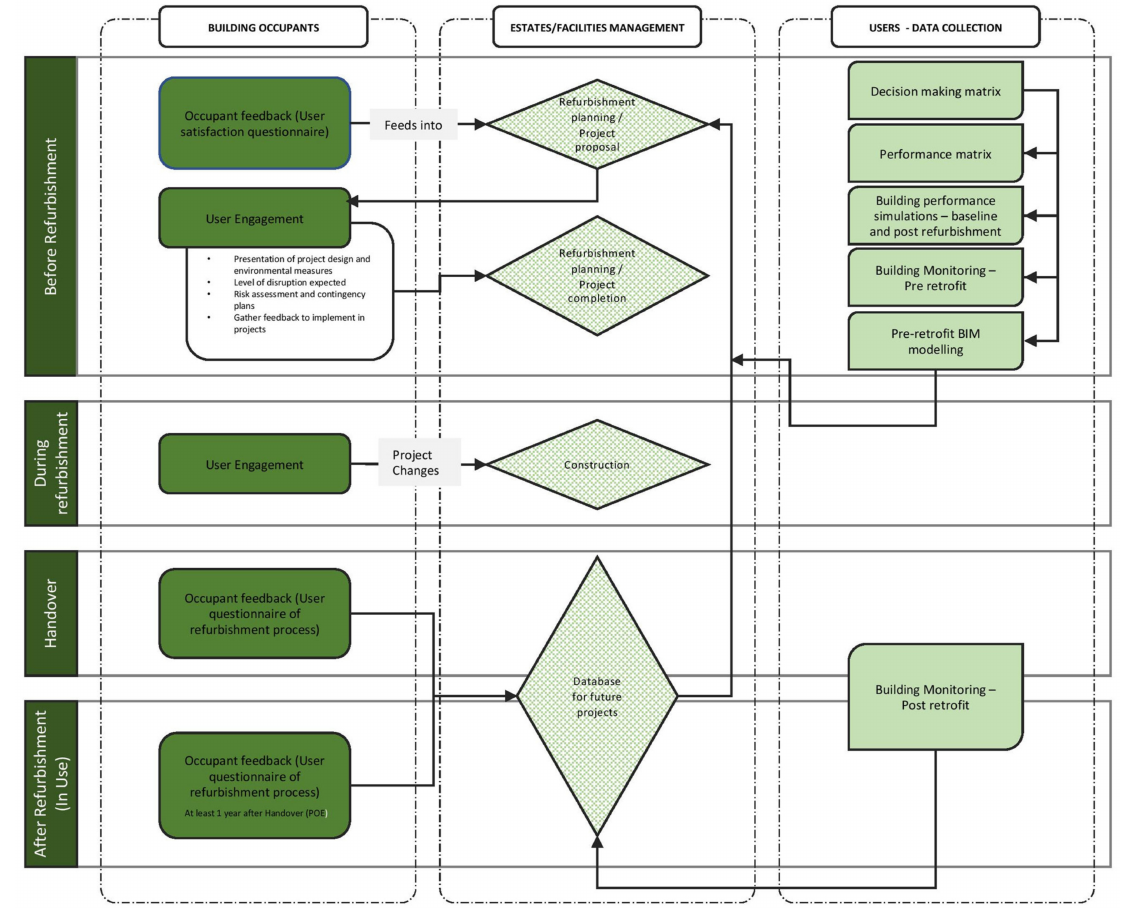
Figure 6. Proposed renovation project user engagement and evaluation